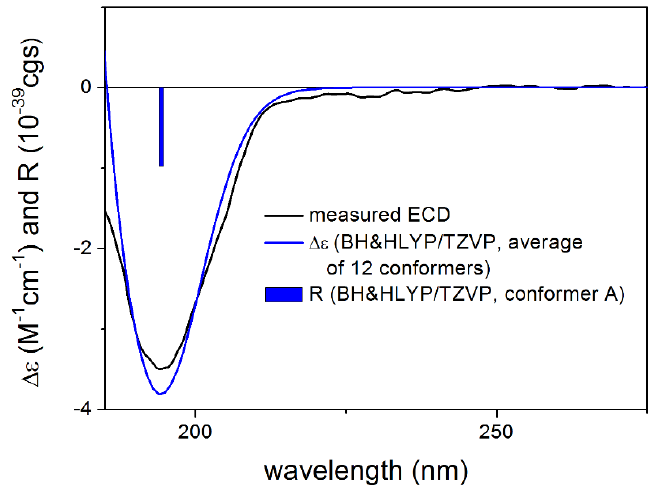
Figure 13. Comparison of the experimental ECD spectrum of 9 measured in MeCN with the BH&HLYP/TZVP PCM/MeCN spectrum of (1 R ,5 S ,6 S ,7 S ,10 R )- 9 (level of optimization: CAM- B3LYP/TZVP PCM/MeCN). The bars represent the rotational strength values of the lowest energy conformer.